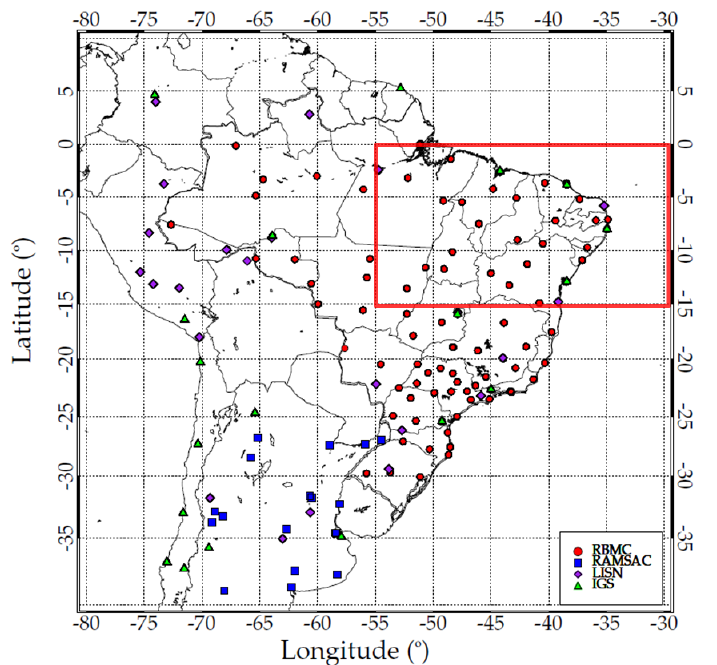
Figure 1. Distribution of the GNSS ground receivers network. RMBC, RAMSAC, LISN, and IGS are represented by red, blue, violet, and green,